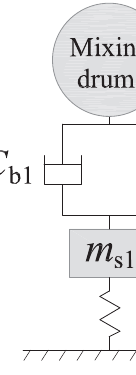
Figure 11. Stiffness and damping model at left supporting point.